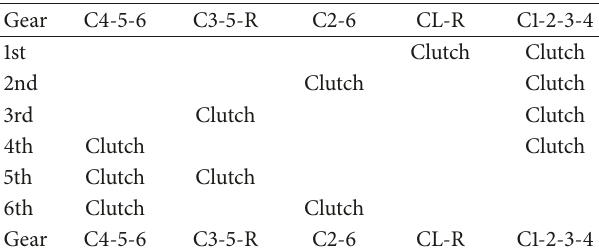
Figure 1: Diagram of neural network shift control. Table 1: Shift